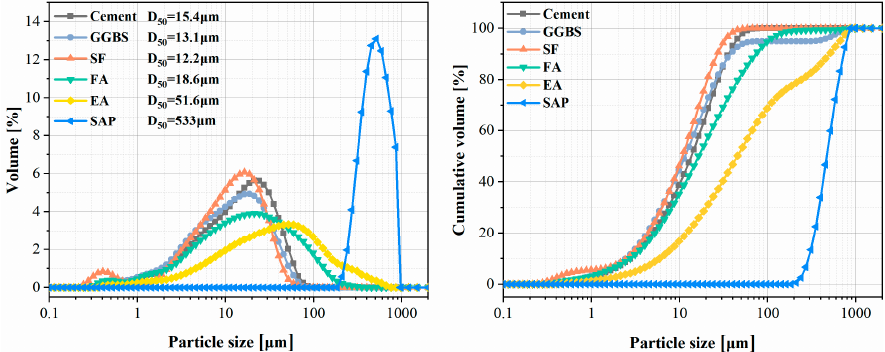
Figure 2. Particle size distribution and cumulative curve distribution of materials.